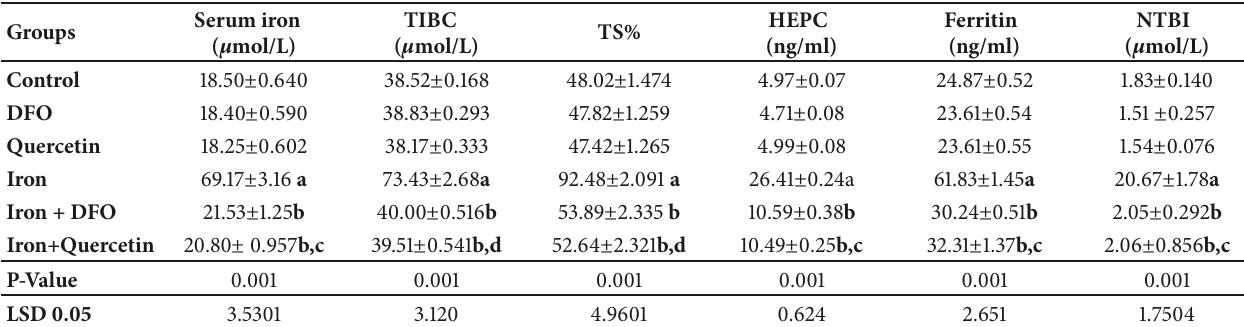
Table 1: Effects of Quercetin in comparison to DFO on serum iron indices in iron overloaded rats. Groups